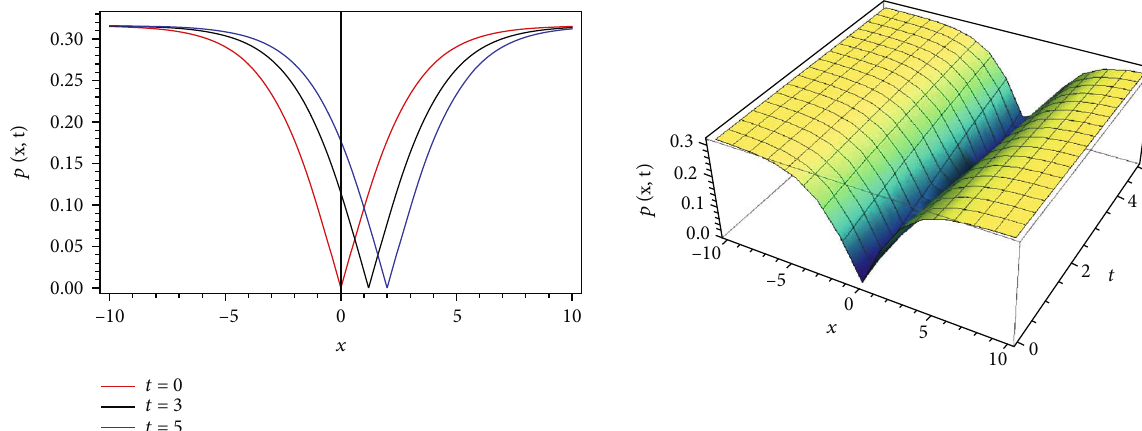
: 1, β : 1, γ : 1, k = 0 : 5, α = 0 : 4, ω j = 0 j = 0 j = 0